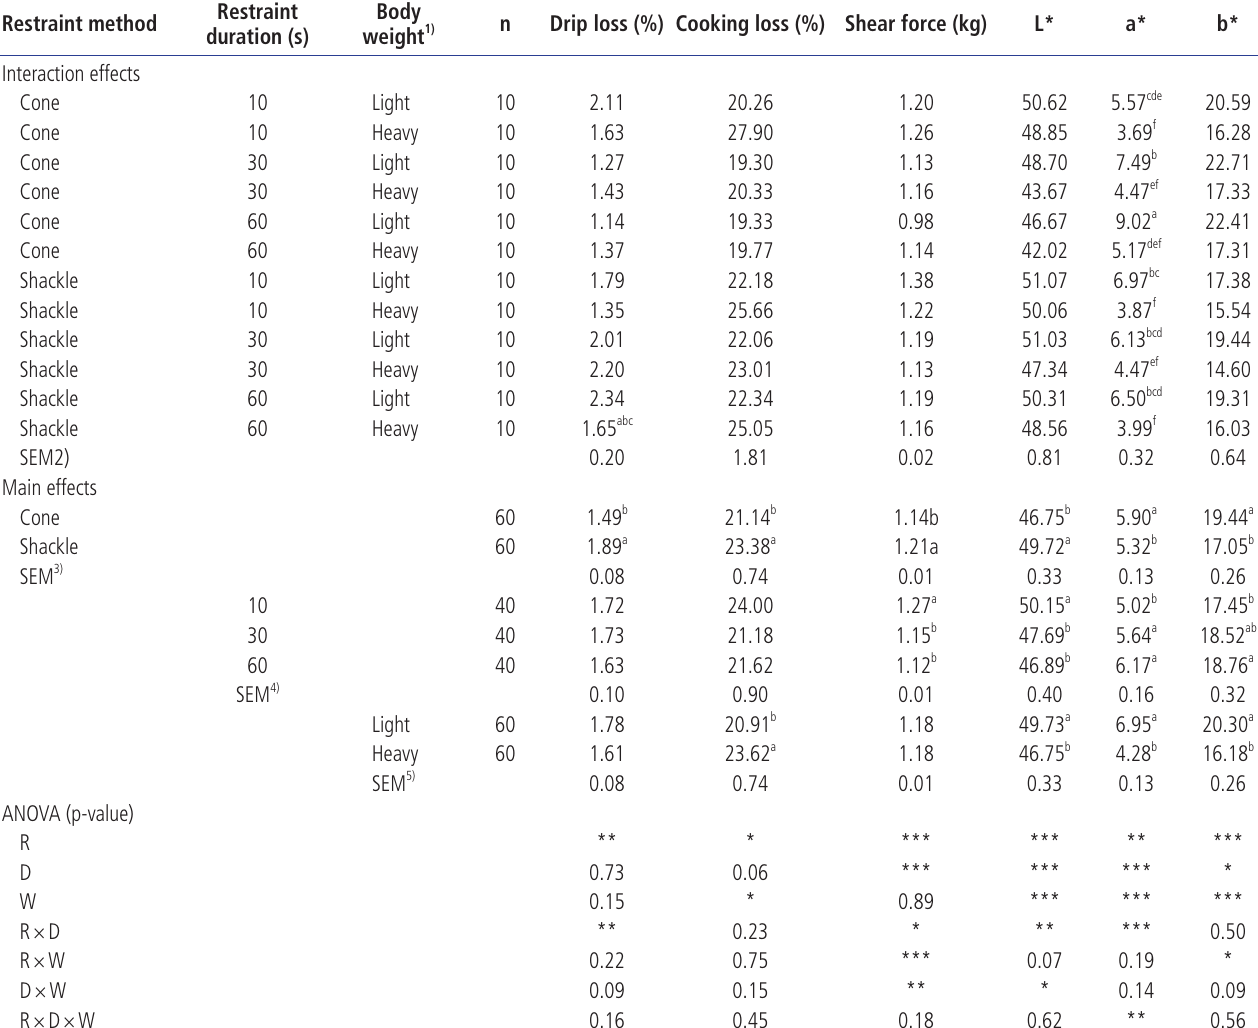
Table 3. Meat quality parameters as affected by restraint method (R), duration of restraint (D), and body weight (W) prior slaughter in broiler chickens Restraint